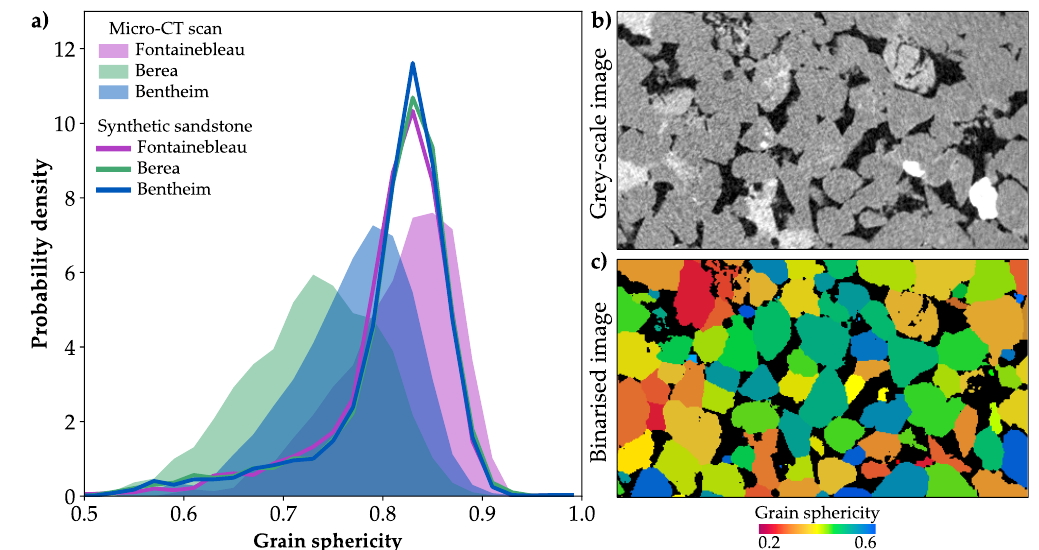
Figure 8. ( a ) Distribution of grain sphericities for the Fontainebleau (magenta), Berea (green) and Bentheim sandstones (blue). ( b ) Micro-CT scan of the Berea sandstone shows granulometric irregularities such as cracked grains, degraded feldspars or carbonate cement patches, which affect the ( c ) sphericity of the watershed segmented grains and are not included in the synthetic